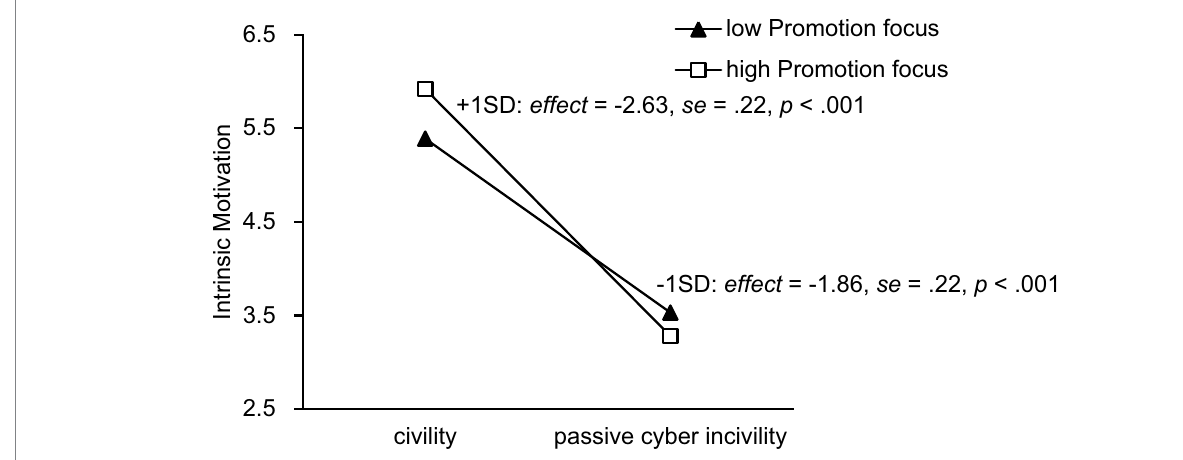
FIGURE 2 Interaction effect of incivility condition and promotion focus on intrinsic motivation.